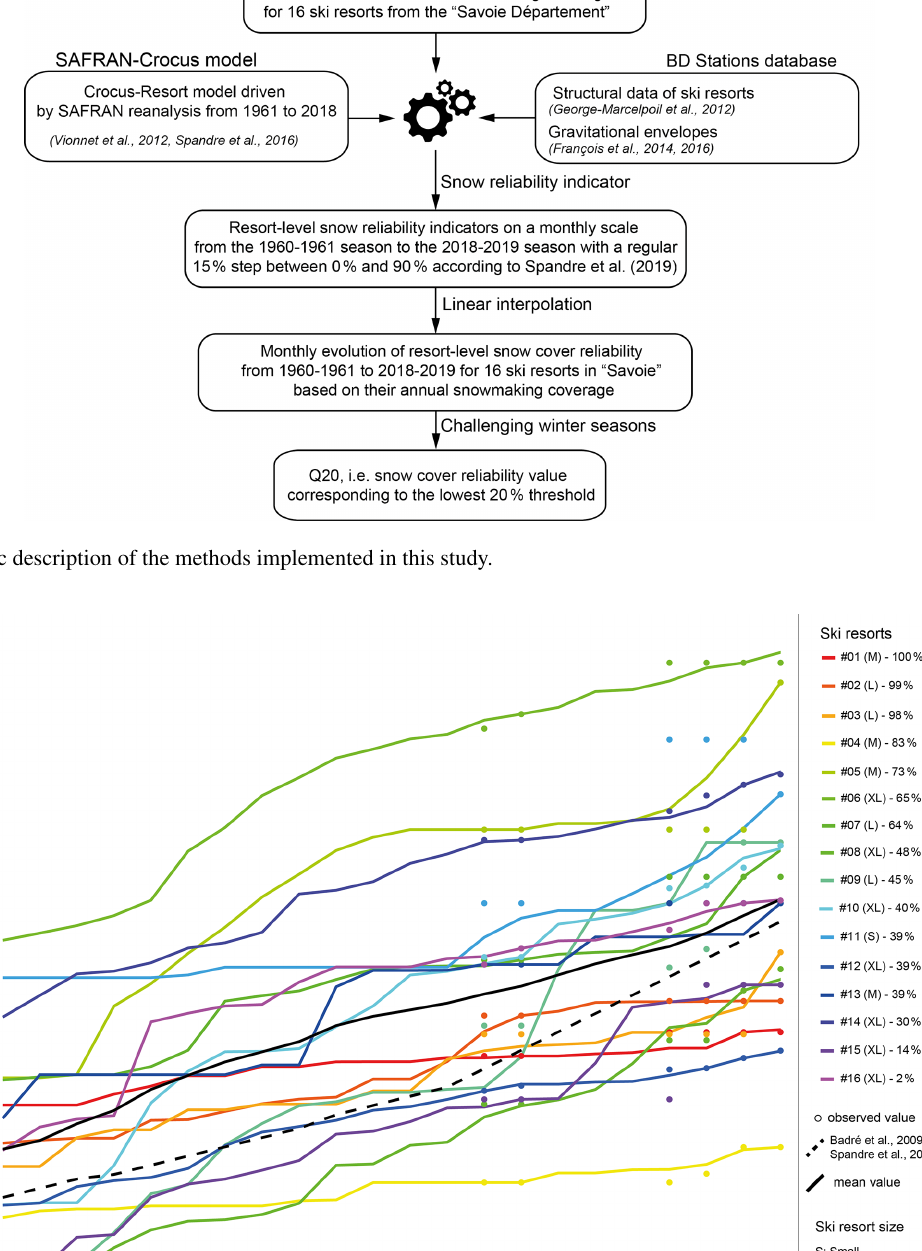
The Cryosphere, 16, 863–881, 2022